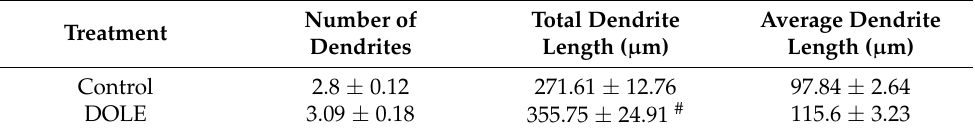
Table 1. Dendricity parameters in HEMn-LP cells after treatment with DOLE at 200 μg/mL for 48 h.